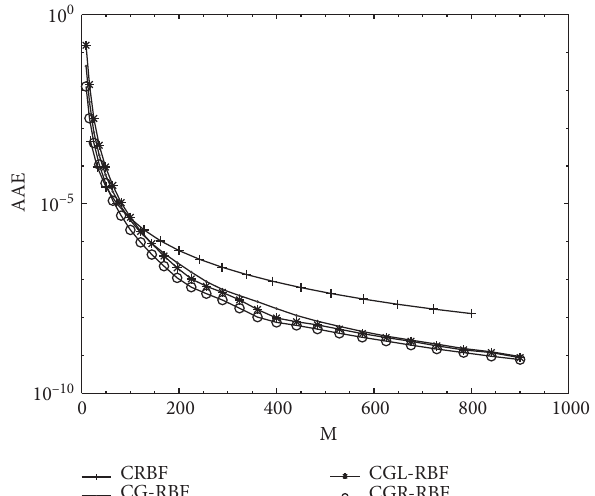
Figure 5: Configuration of the average absolute errors (AAE) for the traditional CRBF and the other three new schemes with fixed m � 5. Table 2: Example 2: relative average errors for the traditional CRBF, CGR-RBF, CG-RBF, and CGL-RBF.